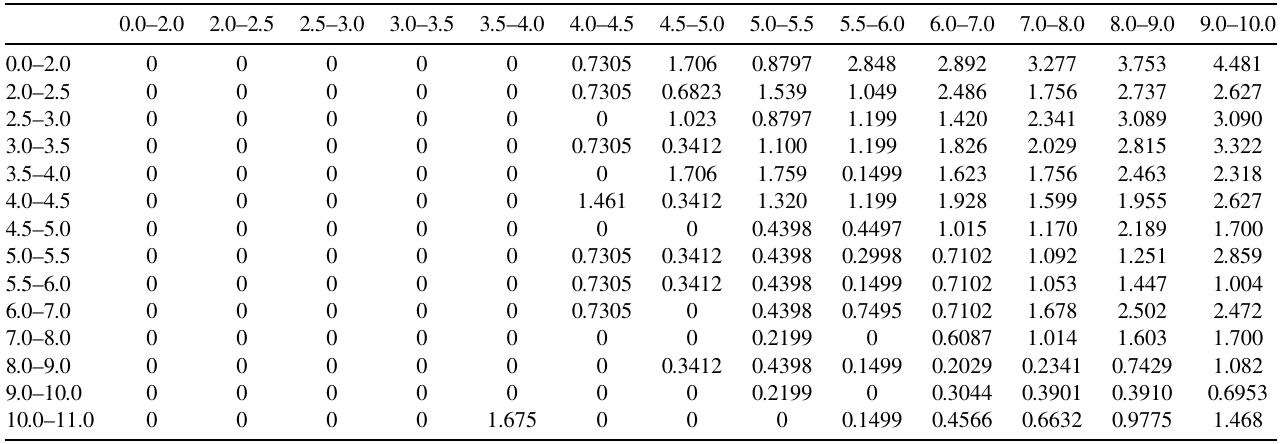
TABLE XVIII. (cid:4) þ background from (cid:3) (cid:5) CC events (all values (cid:2) 10 (cid:1) 4